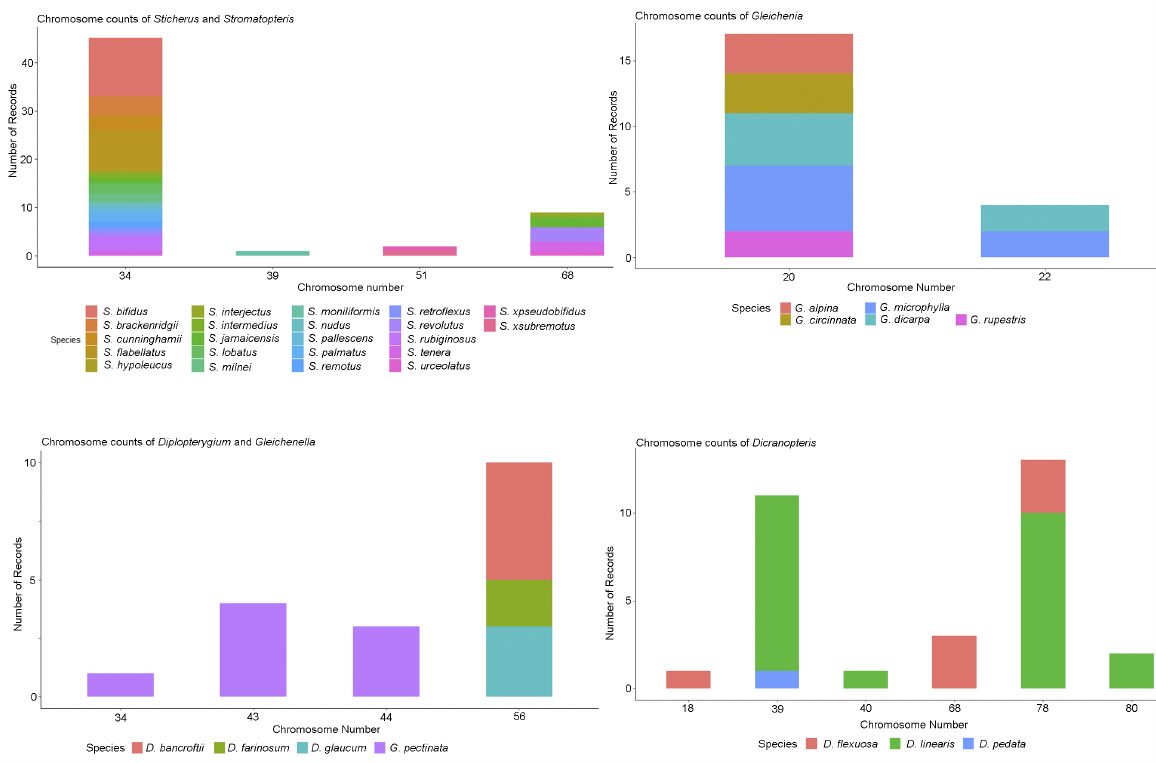
Figure 2. Phylogenetic inference with ancestral chromosome number